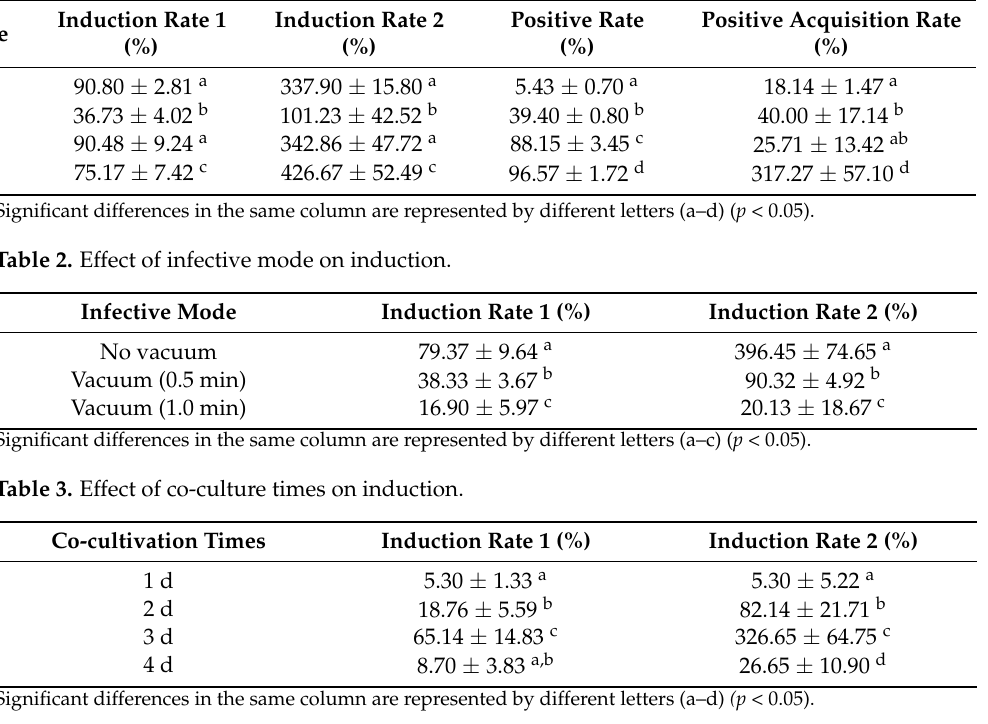
Table 4. Effect of induction medium types on